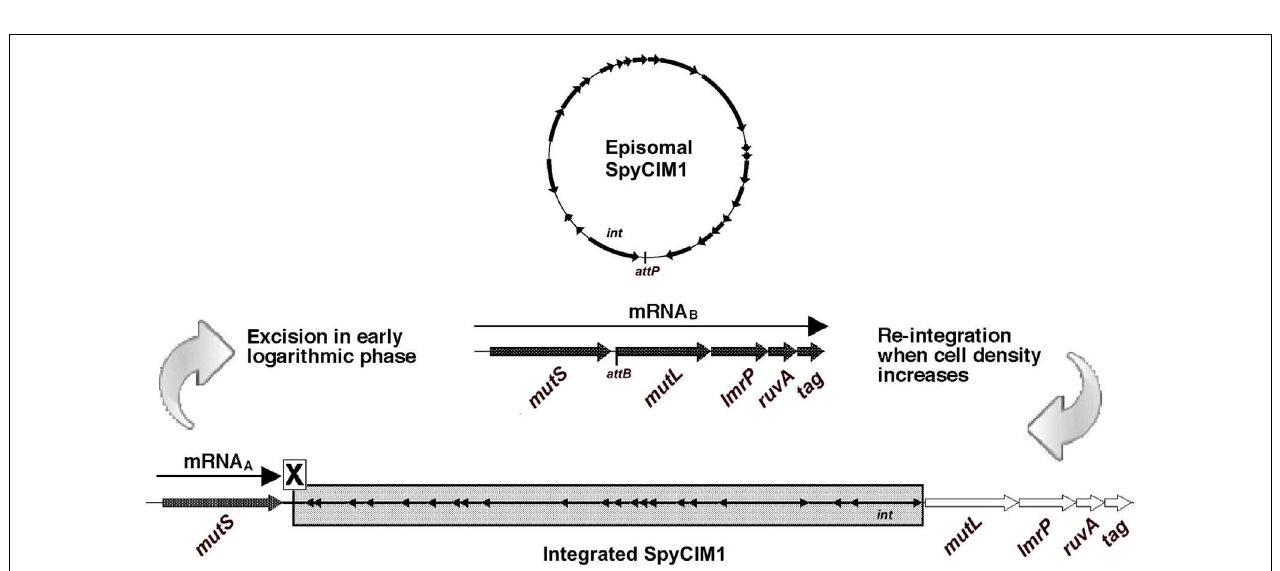
mutS to tag (mRNA B ).The excised phage circularizes and replicates in the host cell as an episome. As cell densities increase, the phage genome integrates into attB located at the 5 (cid:48) end of mutL , returning the cell to the mutator phenotype. Large, unfilled arrows indicate transcriptionally inactive genes of the MMR operon ( mutS , mutL , lmrP , ruvA , and tag), while transcriptionally active ones are large arrows filled in black. Small, filled arrows indicate the SpyCI ORFs; except for int (Scott et al., 2008), the transcriptional patterns of the SpyCI genes are unknown at this